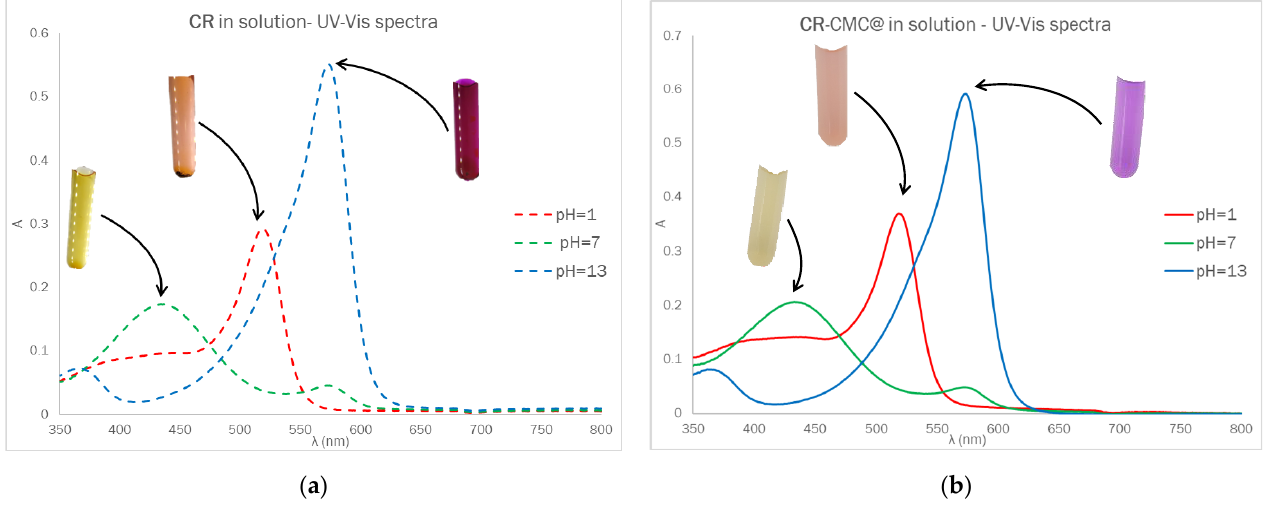
Figure 3. UV-Vis spectra and corresponding photographs of a ~10 μM CR solution ( a ) and 0.5% ( w / v ) CR-CMC@ solution ( b ).